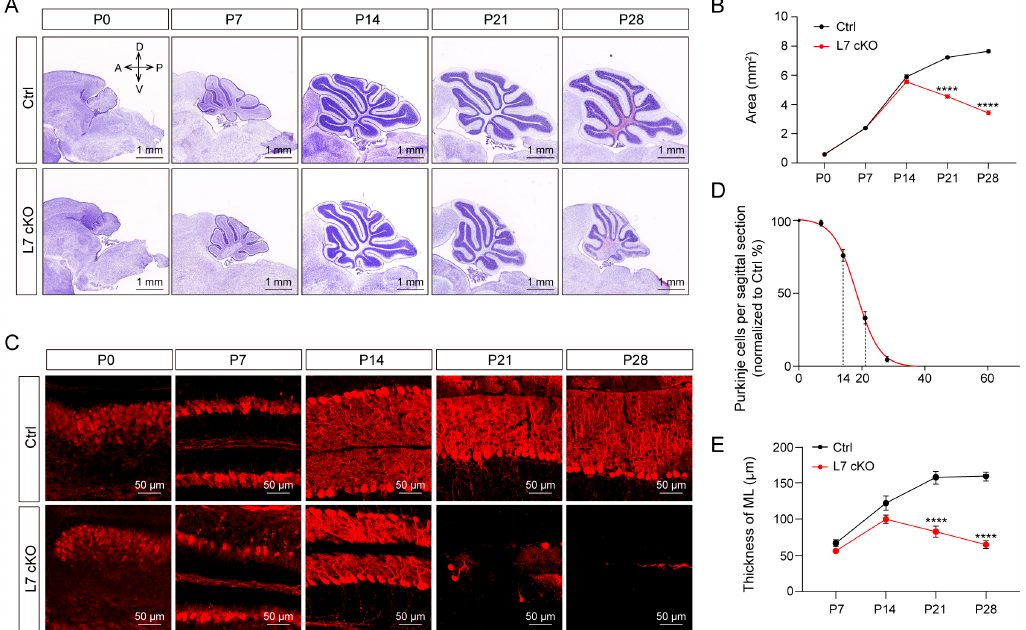
Figure 1. Loss of OGT in PCs induces cerebellar atrophy and PCs loss . ( A ) Nissl staining of sagi tt al histological sections of the cerebellar vermis showing cerebellar atrophy (scale bar: 1 mm). ( B ) Quan- ti fi cation of the area of the sagi tt al sections of the cerebellar vermis for the Ctrl and cKO mice (mean ± SEM; **** p < 0.0001, n > 3). ( C ) Immuno fl uorescent staining with anti-calbindin antibody (red) to reveal PCs in the cerebellar vermis (scale bar: 50 µm). ( D ) PCs per sagi tt al histological section of the cerebellar vermis is expressed as a percentage for the Ctrl mice. ( E ) The ML thickness of the cKO and Ctrl mice (mean ± SEM; **** p < 0.0001, n > 3). a, anterior; d, dorsal; p, posterior; v, ventral; ML, molecular layer.